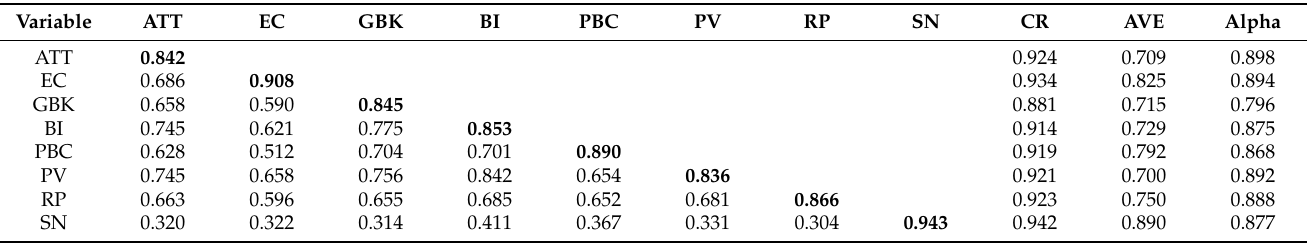
Table 2. Correlation of latent variables and square roots of